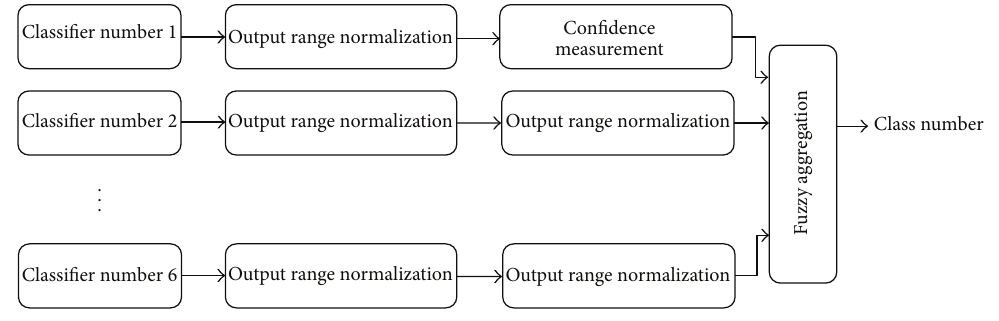
Figure 1: Block diagram of the proposed fuzzy data fusion method.